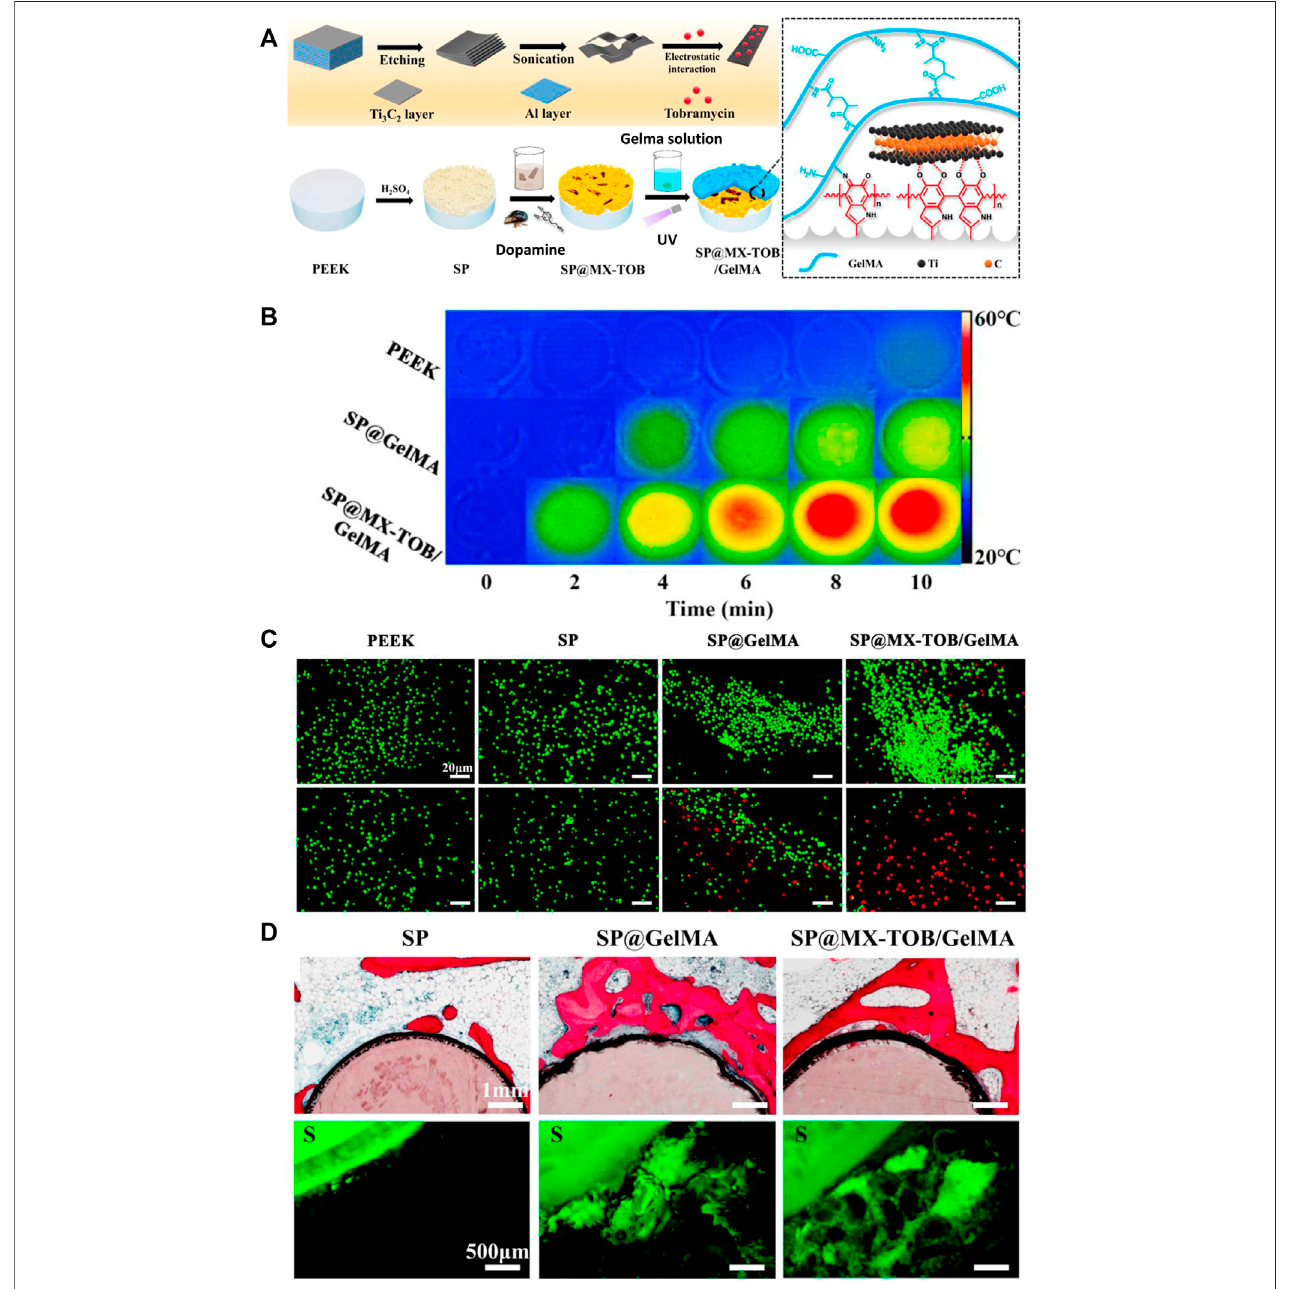
FIGURE 11 | The PDA-based multilayered coating with multiple functions for tumor suppression and osteogenesis. (A) Schematic illustration of the coating fabrication. (B) Photothermalheatingcurvesofdifferentsamples. (C) Live/Dead fl uorescentstainingoftumorcells. (D) Invivo evaluationofosteogenicactivity.** p < 0.05 and ** p < 0.01 (Yin et al., 2020). Copyright 2020, American chemical society.